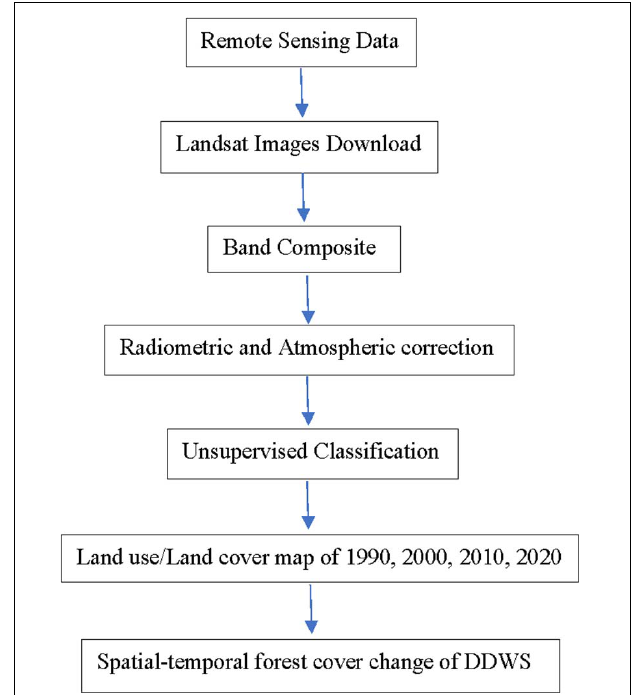
FIGURE 1 | Flow chart of land use and land cover classification process in Landsat 5, 7, and